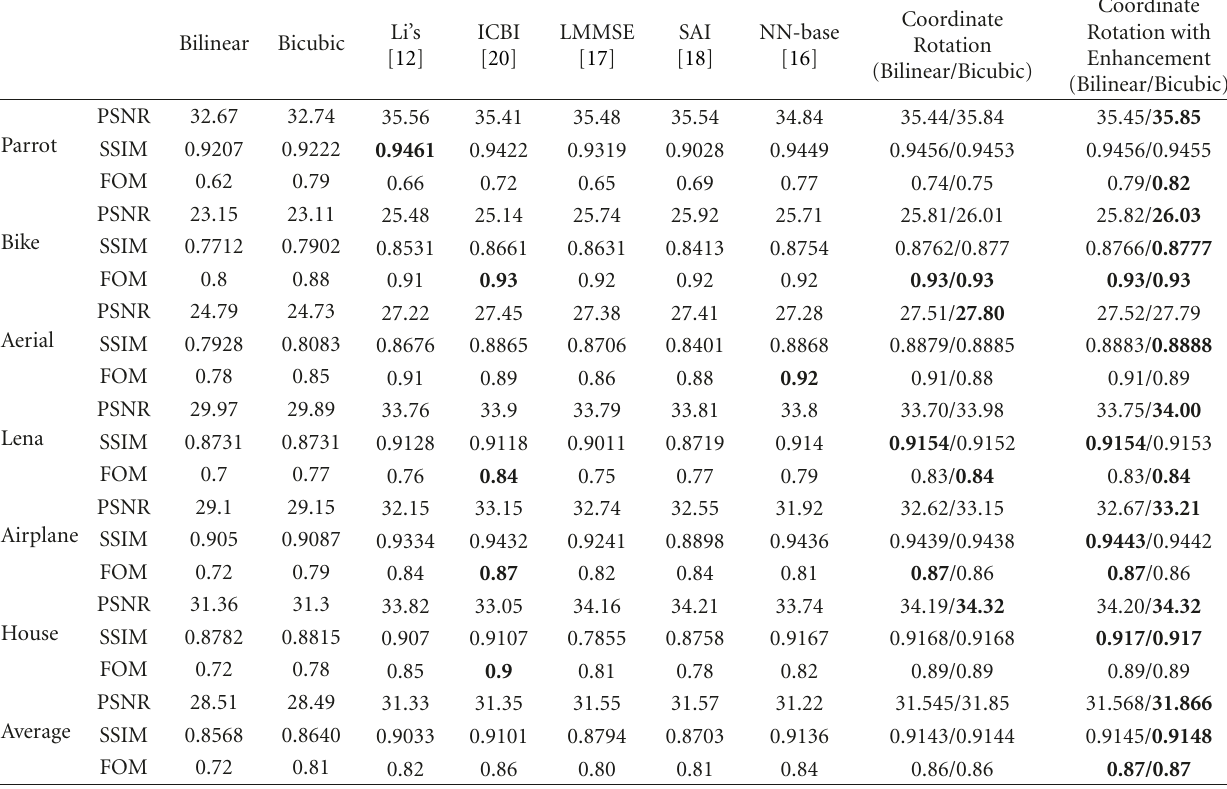
Table 3: Comparative results in PSNR, SSIM, and FOM of di ff erent algorithms applied to various kinds of resolution enhancement images. The best results are denoted in bold.